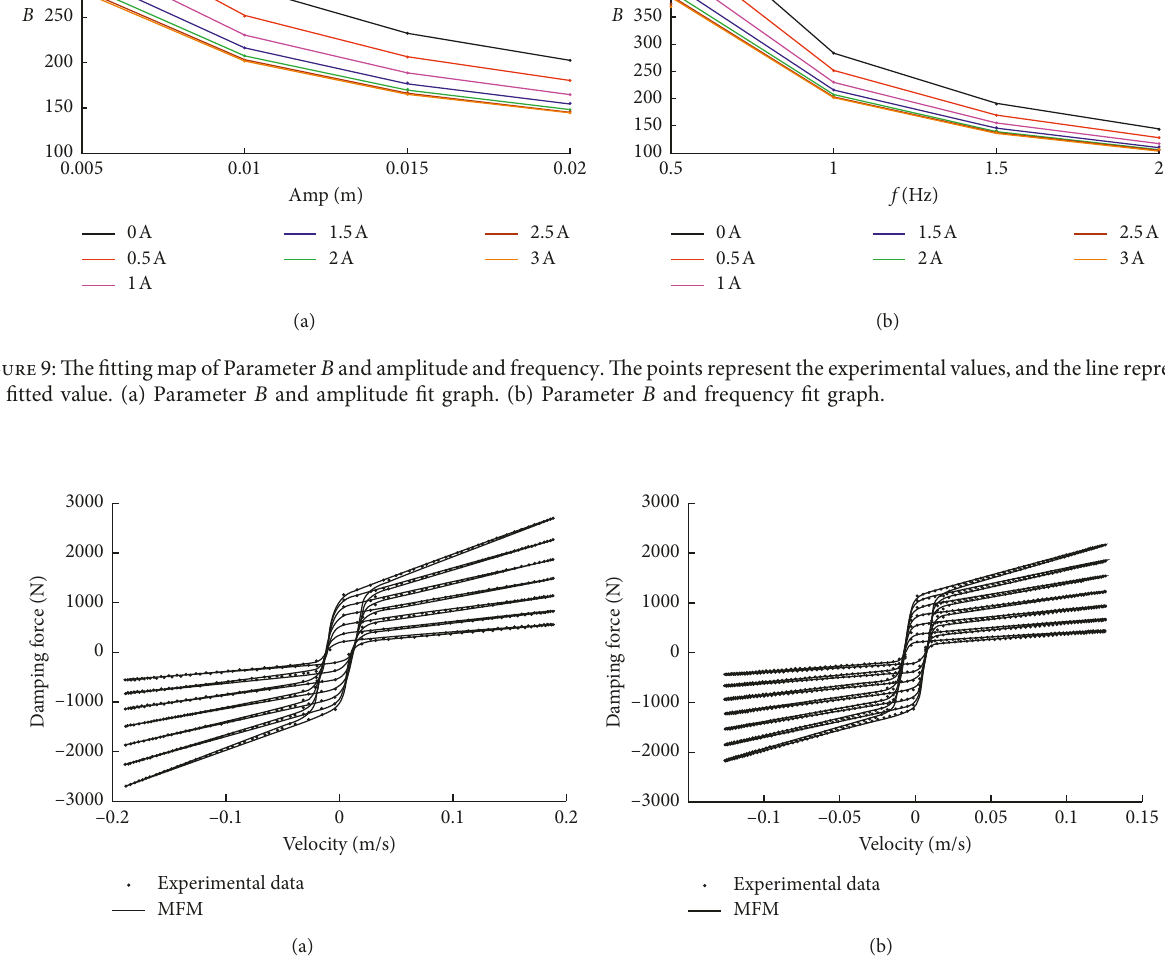
Figure 10: Comparison of magic formula model and experimental data under different operating conditions. (a) When Amp f 2Hz, the piston speed-damping force curve at different currents. (b) When Amp (cid:31) curve at different